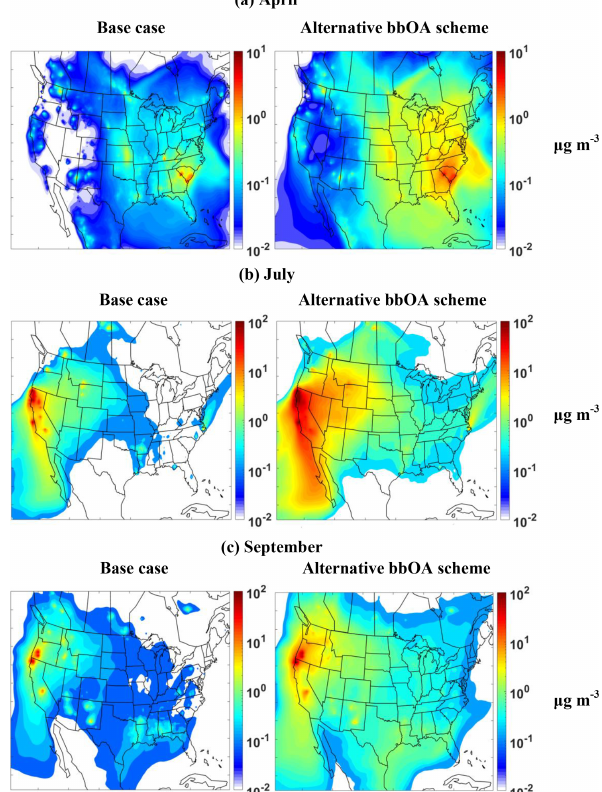
Figure 5. PMCAMx-SR-predicted ground-level concentrations of bbSOA-sv and bbSOA-iv from all biomass burning sources during (a) April, (b) July, and (c) September 2008. Left column refers to the base case simulations and right column to the simulations with the alternative bbOA scheme. All concentrations are in µgm − 3 .